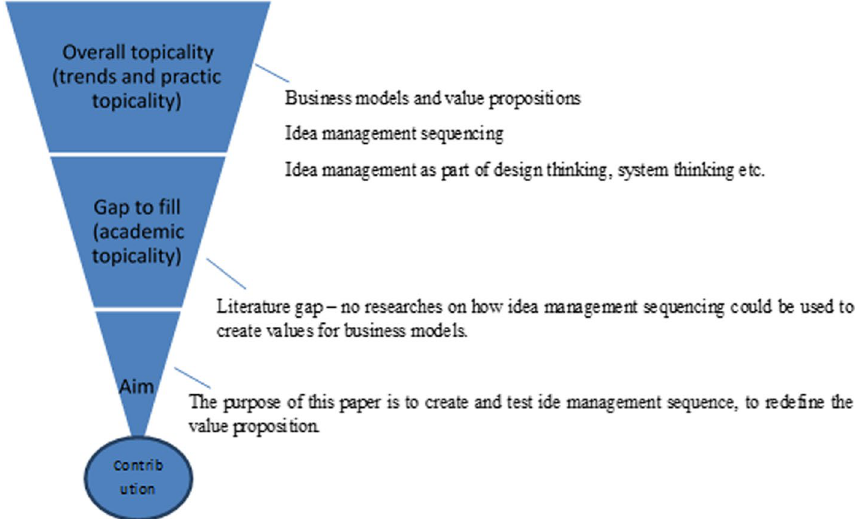
Fig. 1 Research categories, gaps and motivation (source: the